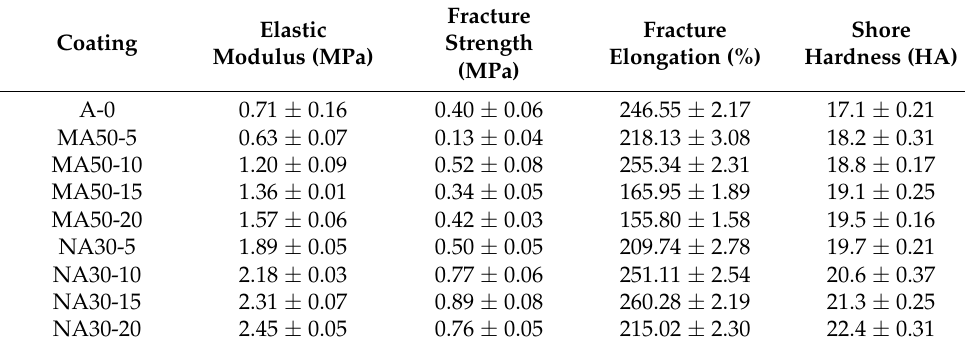
Figure 7. Stress-strain curves of tested coatings: ( a ) Micro-alumina, ( b ) Nano-alumina. Table 2. Mechanical properties of Al 2 O 3 reinforced PSO/PDMS coatings.